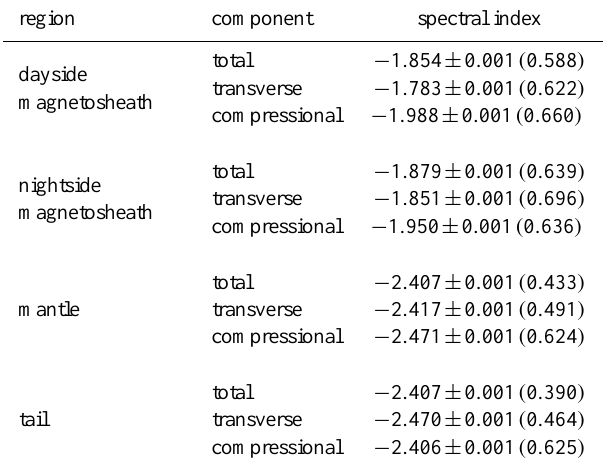
Table 1. Observed spectral indices with its standard deviations of the mean in Venus’ solar wind interaction region. The values in brackets represent the sample standard